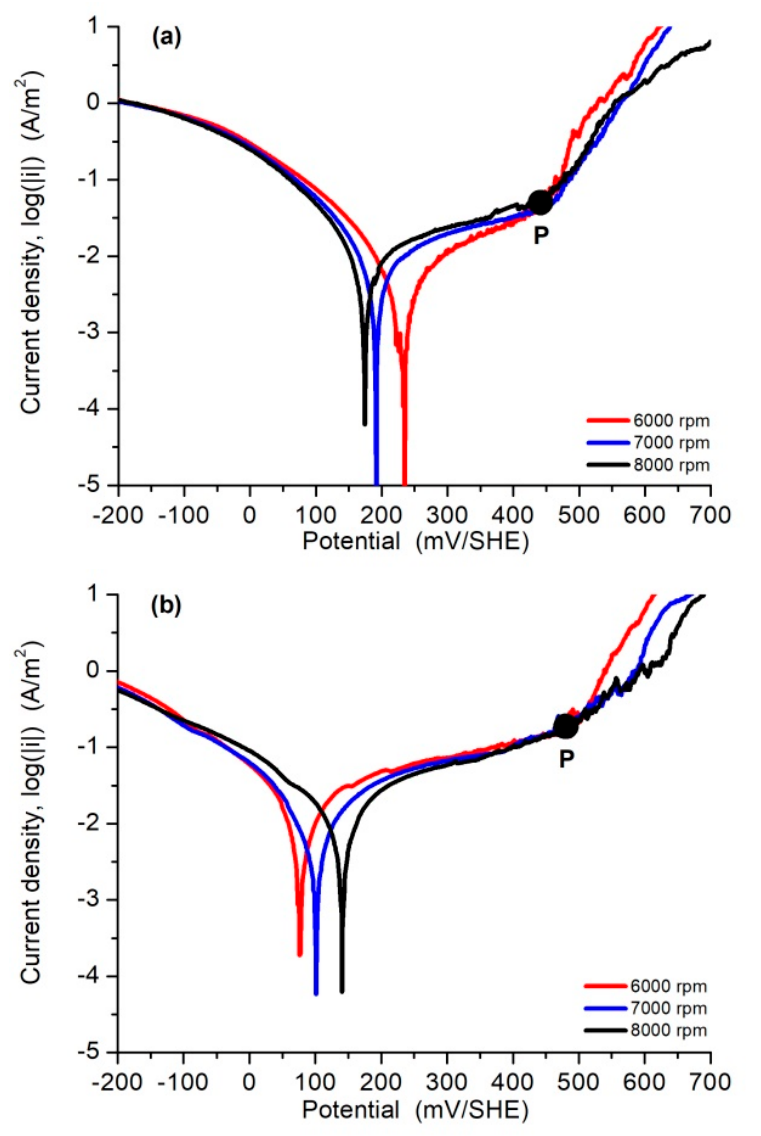
Figure 6. Tafel polarization curves for AISI 304L stainless steel electrodes immersed in the aerated 0.5 M NaCl ( a ), and filtrate solution form tailings slurries ( b ).